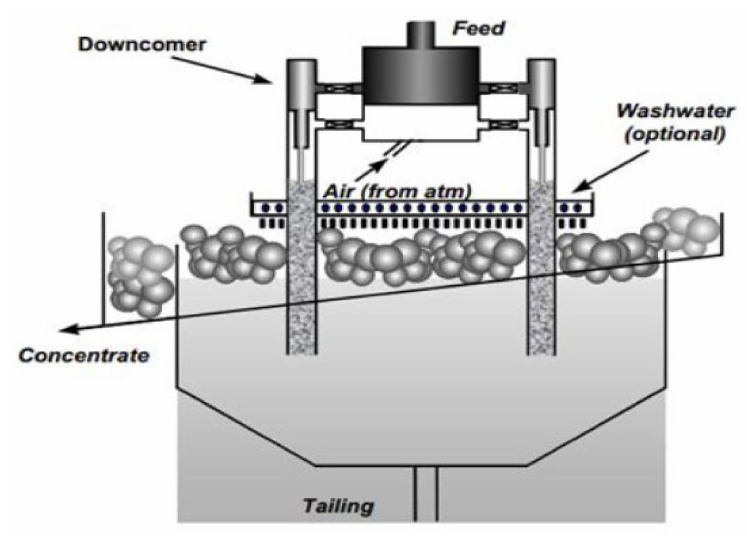
Figure 11. Jameson cell with a froth washing system